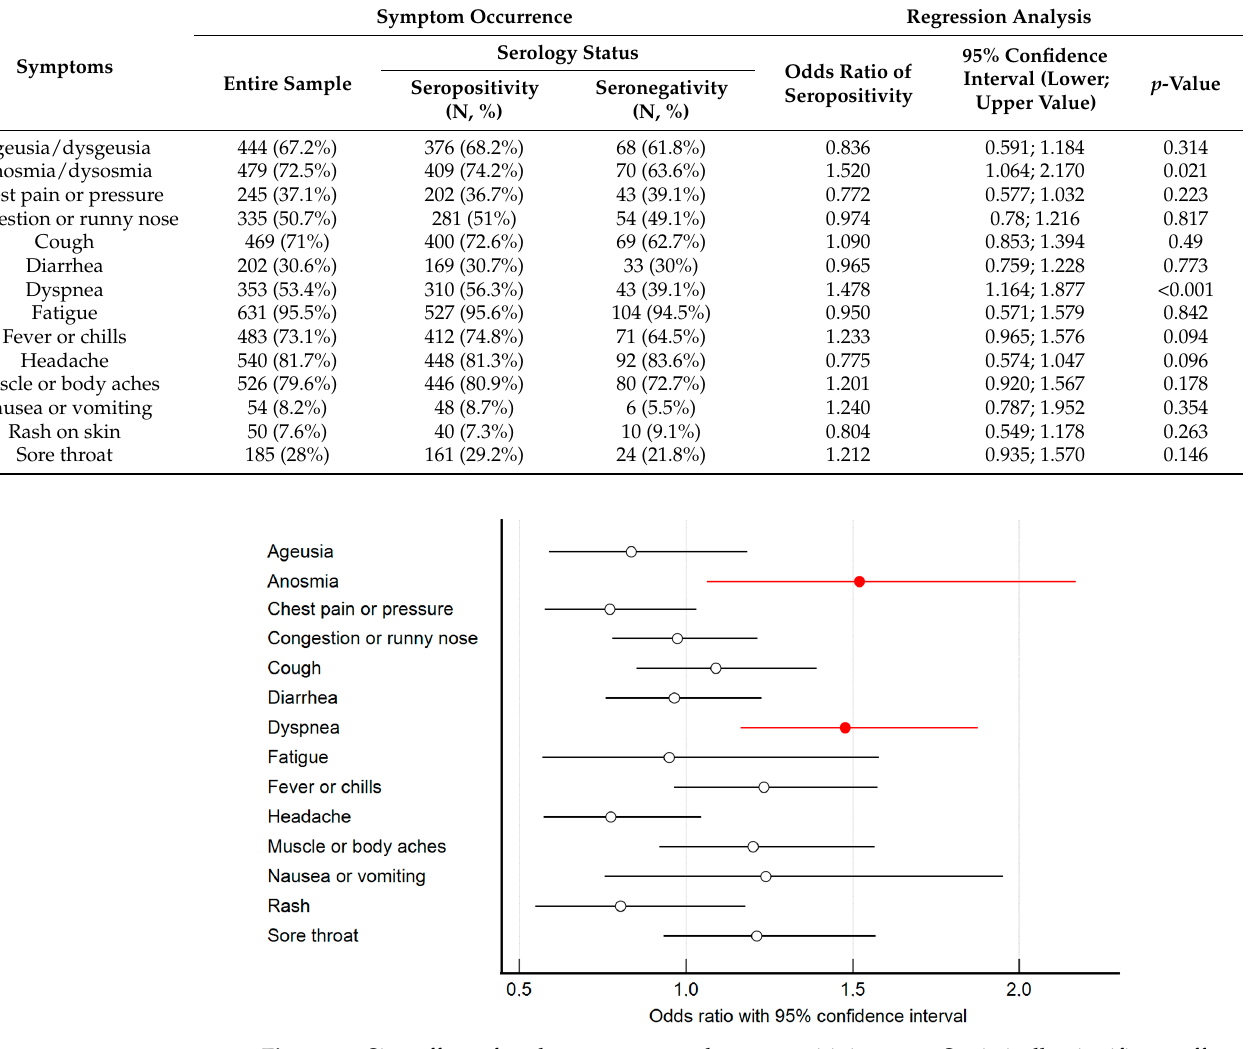
Figure 2. Immunoglobulin G seropositivity rate respectful to symptom clusters. * Statistically sig- nificant. In addition to the common symptoms of the acute phase of COVID-19, some others were stated. Specifically, 64 HCWs reported mental disorders (anxiety, irritability, insom- nia) in the acute phase, 27 HCWs reported skin problems (itchy or burning skin, hair loss), 20 HCWs reported eye problems (painful, itchy, or burning eyes), and 16 HCWs reported painful or clogged paranasal sinuses.